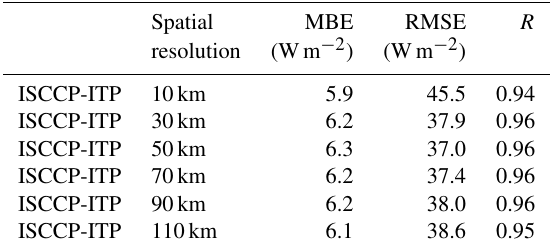
Table 2. Effect of spatial resolution (from 10 to 110km) on ac- curacy of our estimated instantaneous PAR product (ISCCP-ITP) compared to observations at the 42 NEON stations. Spatial MBE